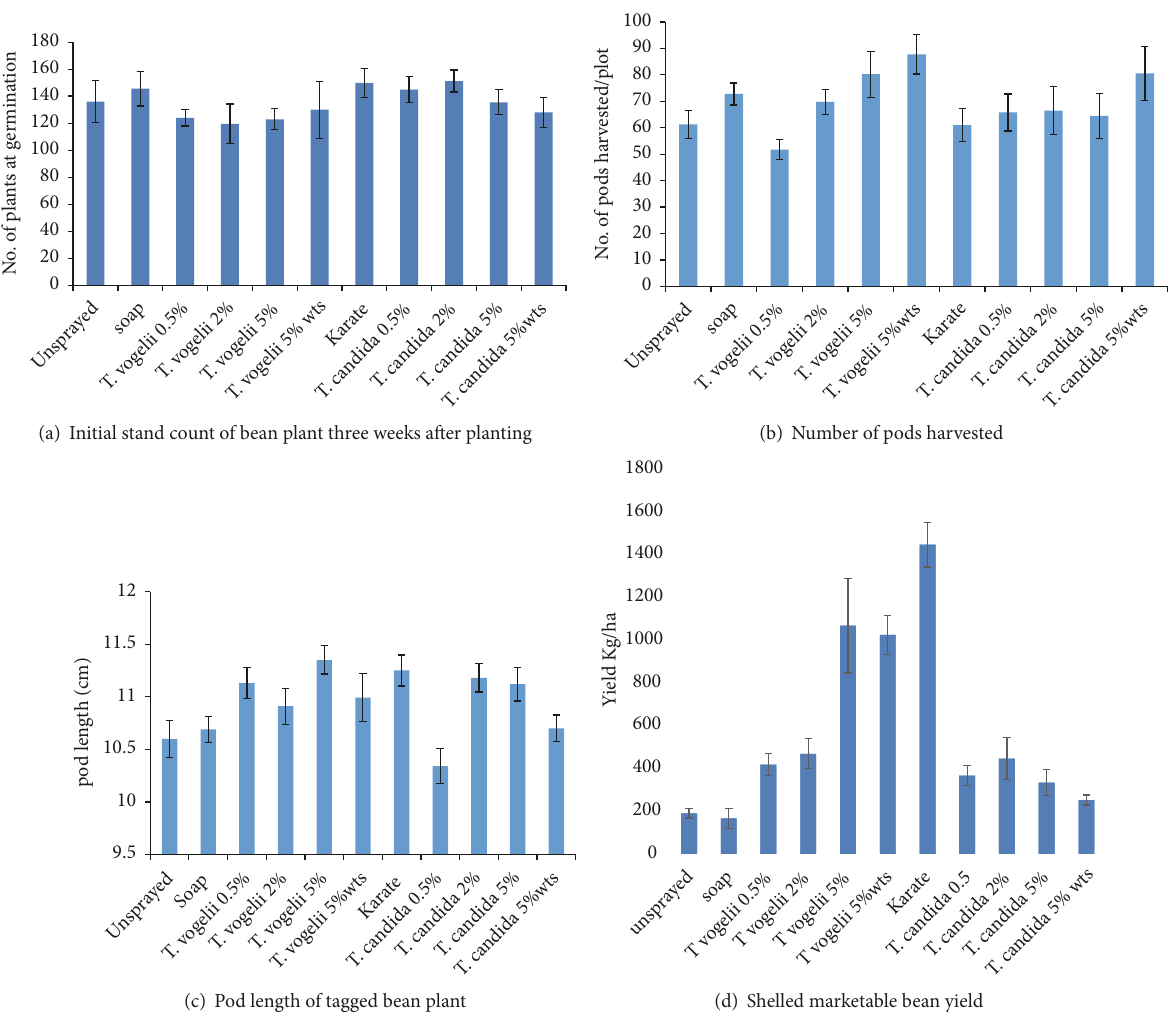
Figure 1: Effect of Tephrosia vogelii and Tephrosia candida on bean